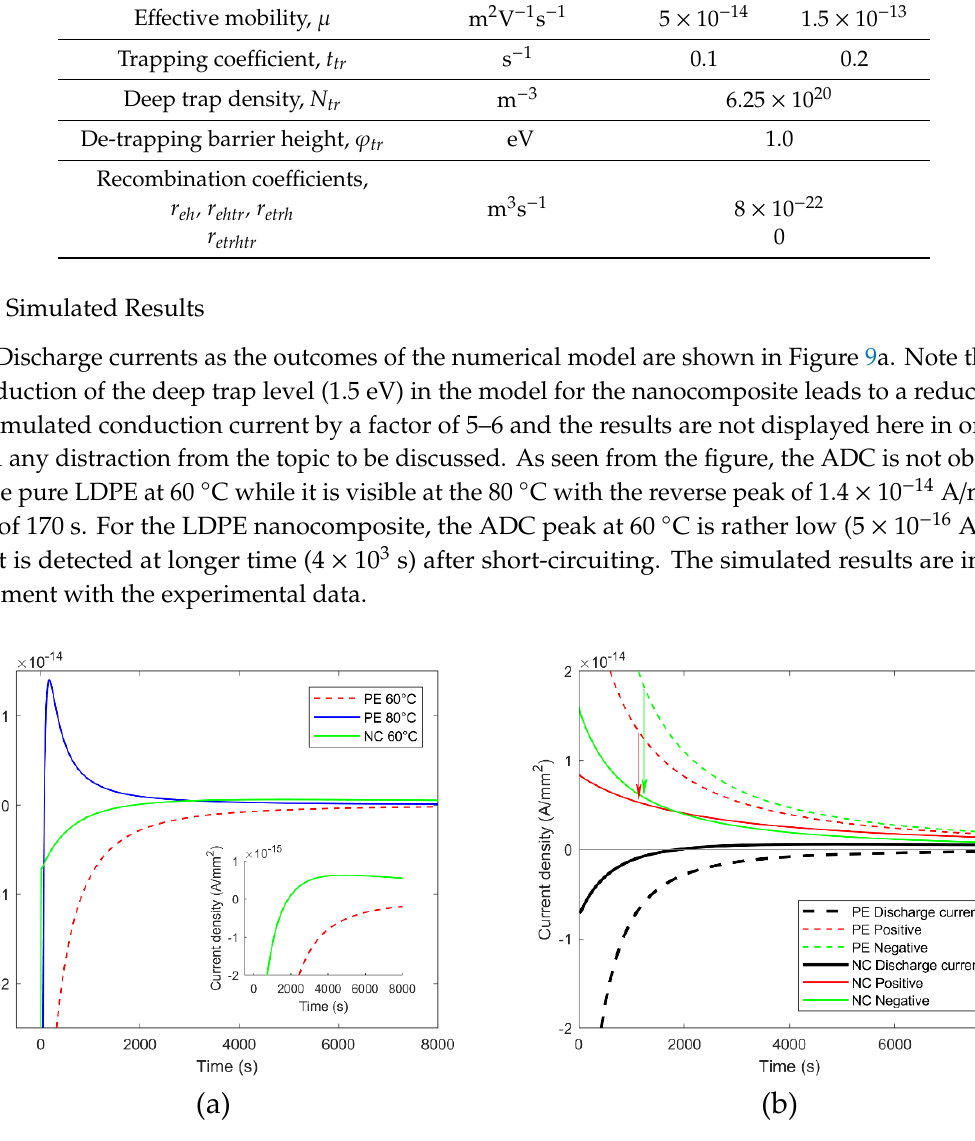
Table 6. Parameters of the charge transport model used in the present study. Parameter Unit Schottky injection barrier, ϕ eV 1.16 E ff ective mobility, µ